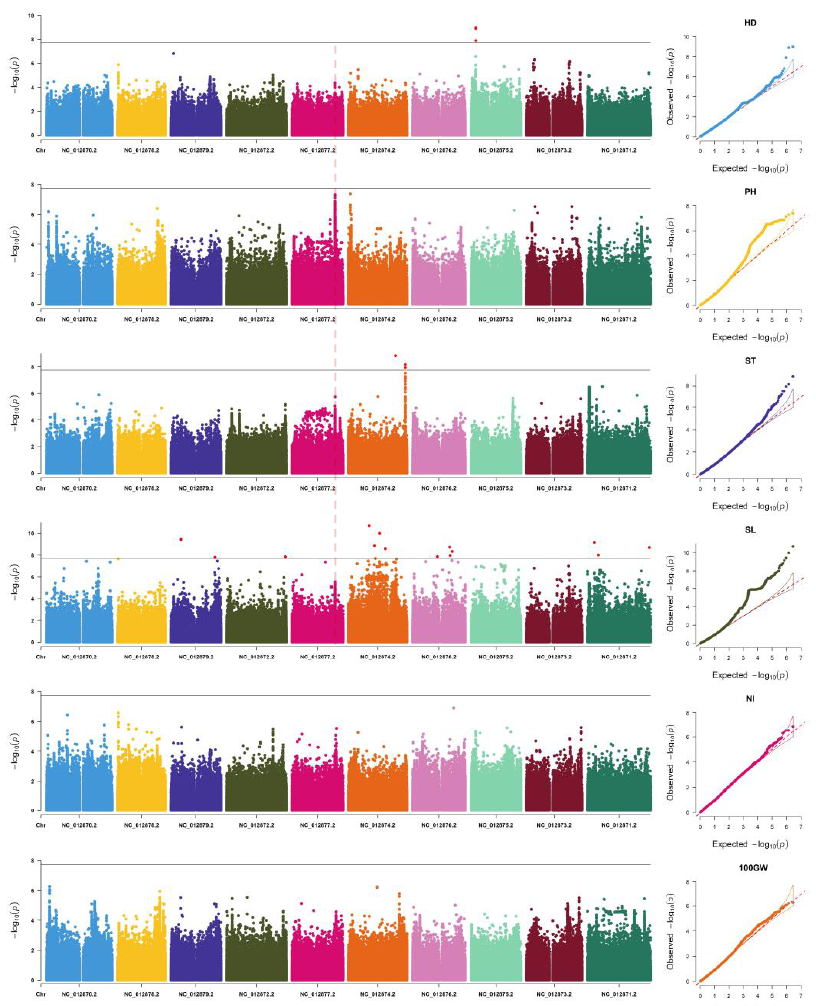
Figure 3. The Manhattan and Q-Q plot of six traits, including heading date (HD), plant height (PL), spike type (ST), spike length (SL), number of internodes (NI), and 100-grain weight (100 GW), based on the emmax algorism. The light red dash line indicates the QTL that was identified in four traits.